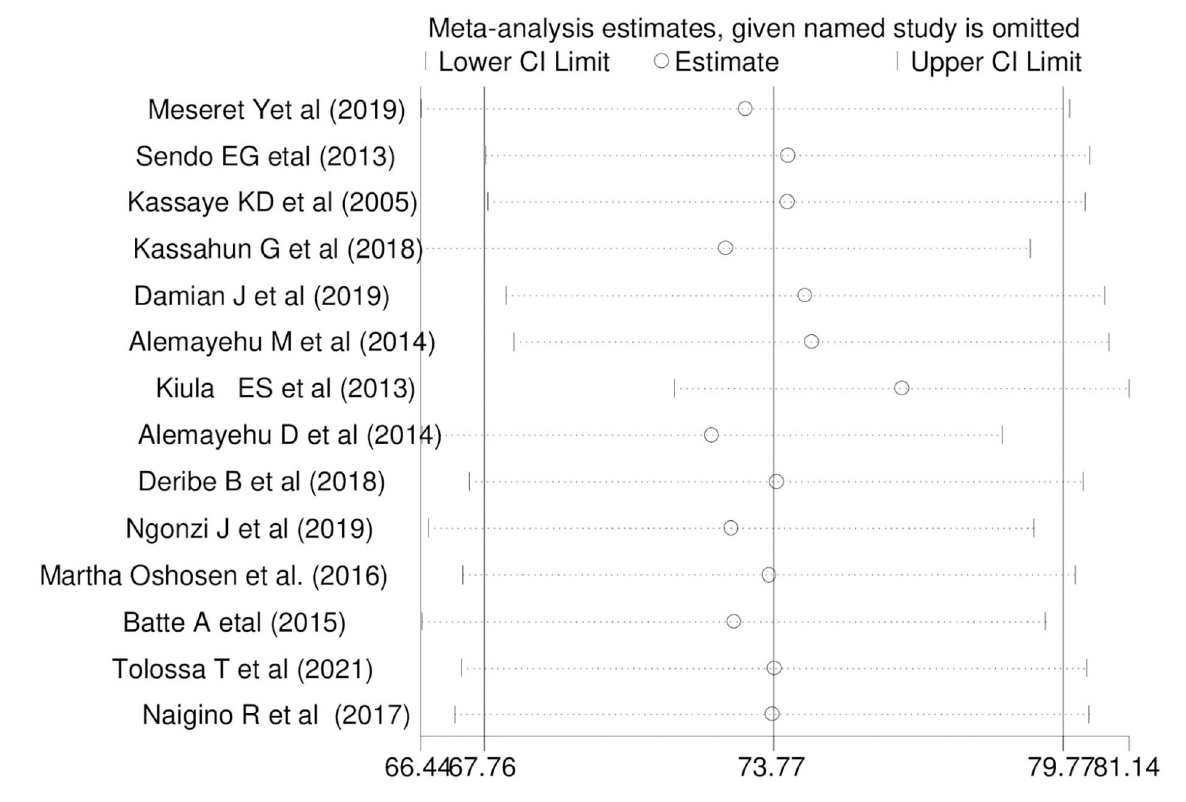
40.80% (95% CI: 34.71, 46.89) (33). Due to